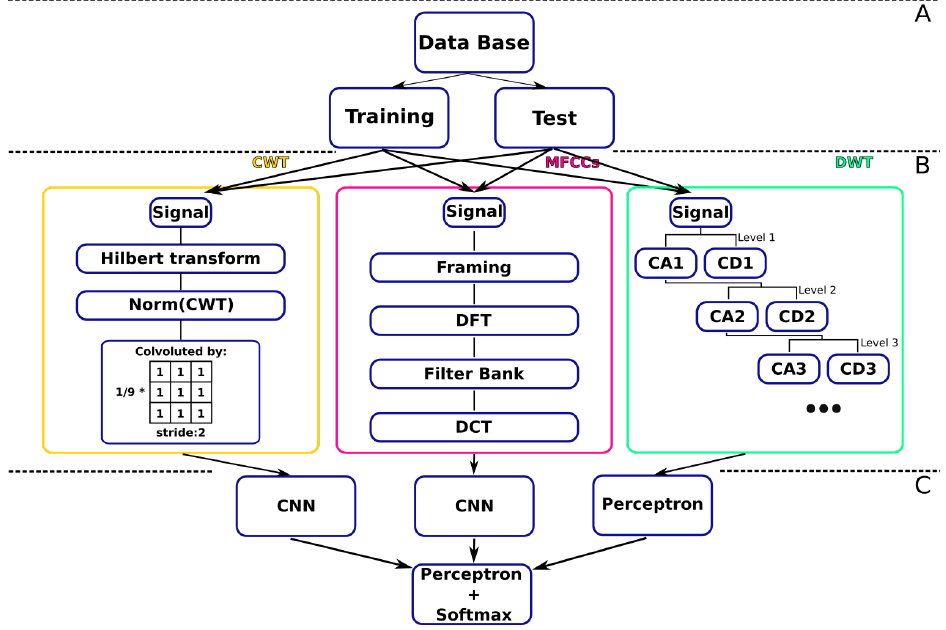
Figure 6. DNN block diagram: The diagram shows the proposed architecture. ( A ) Partition of the dataset into the training and test sets is exemplified. ( B ) Feature extraction techniques. ( C ) Classification algorithms